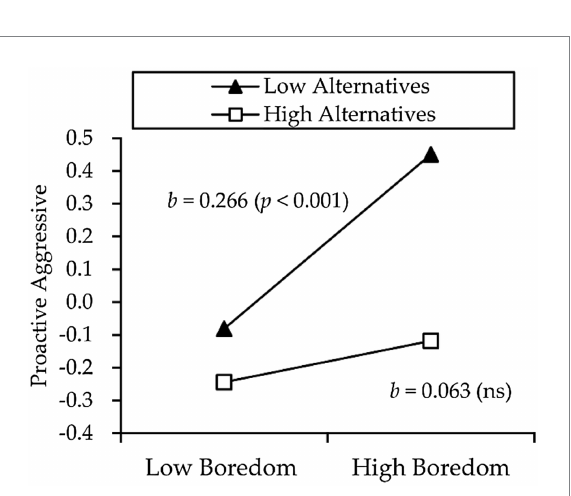
FIGURE 3 Moderation effect of alternatives on the relationship between boredom and proactive